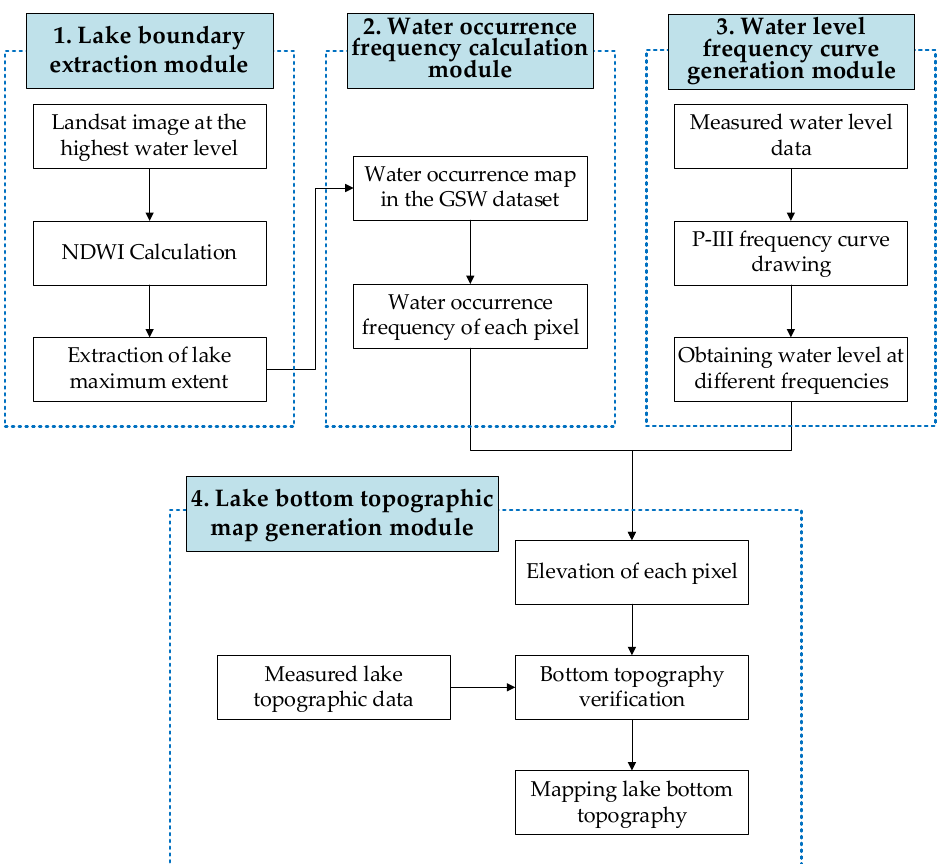
Figure 2. Flowchart of the proposed method to estimate bottom topography of lakes: the method consists of four modules.